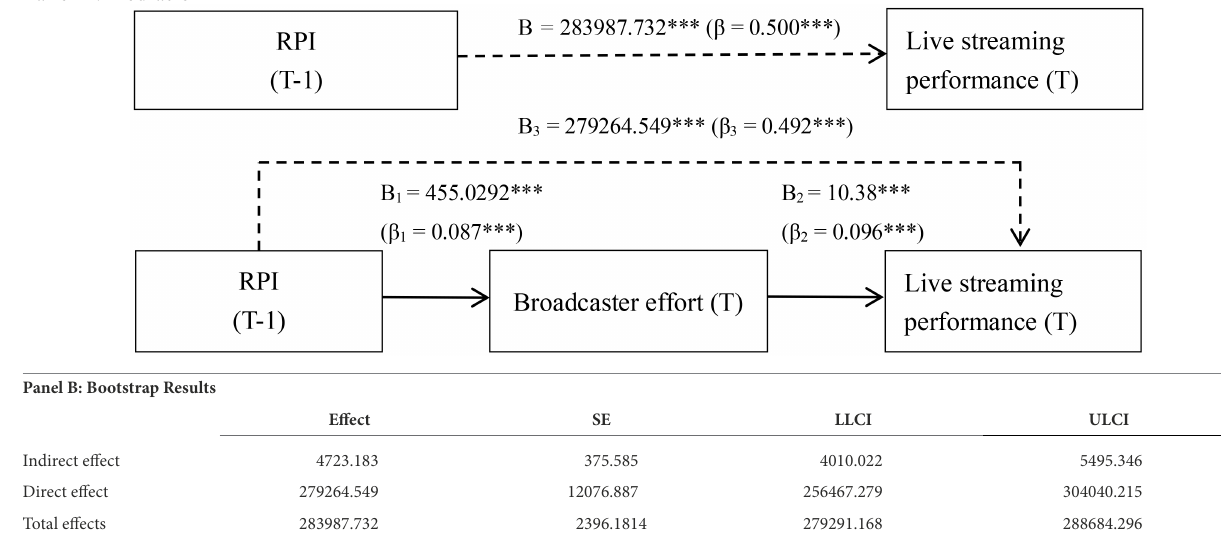
TABLE 2 Mediating effect of broadcaster effort.